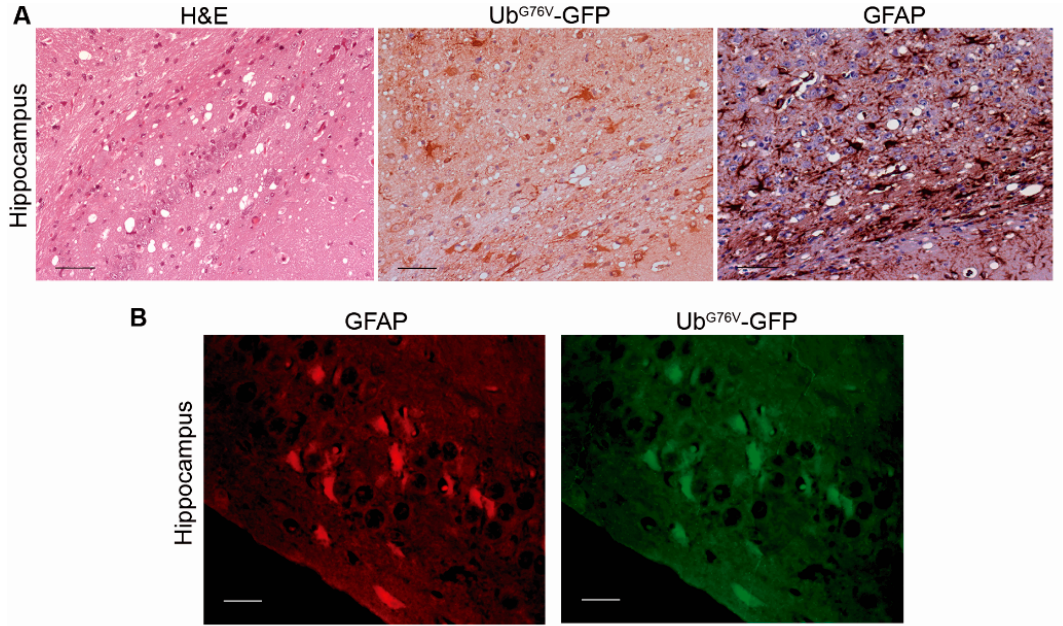
Figure 5. Ub G76V -GFP intracellular accumulation is observed in brain areas showing prion-associated neuropathology. ( A ) Hippocampus from a clinical TgU1 + /TgVole + mouse stained with hematoxylin and eosin and immunostained for Ub G76V -GFP and glial fibrillary acidic protein (GFAP). This animal shows severe spongiosis in the hippocampus and intense immunostaining for Ub G76V -GFP and GFAP. Strong Ub G76V -GFP immunolabeling is observed, affecting numerous cells that appear to be reactive astrocytes. ( B) Dual immunofluorescence staining with anti-GFAP and anti-GFP antibodies revealed that numerous reactive astrocytes accumulated the Ub G76V -GFP reporter, suggesting that these cells can compensate for proteasome impairment and accumulate high amounts of ubiquitin conjugates before succumbing to the cytotoxic